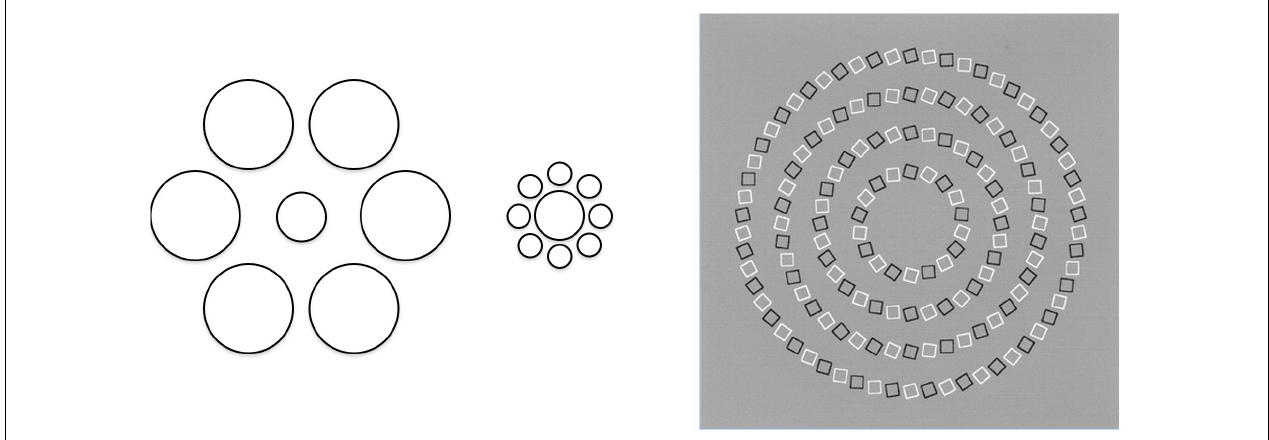
FIGURE 7 | The Titchener and the Pinna illusions. In the Titchener, the central circles as the same size; in the Pinna, the rings are all concentric circles; illusions of distortion of visual